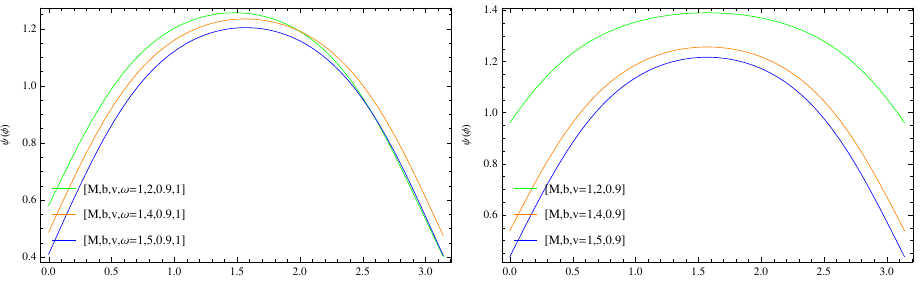
Figure 2. ( left ) Trajectory of the particle is shown, i.e., U ( φ ) against φ for different values of the impact parameter b . ( right ) U ( φ ) is shown against φ for different values of the impact parameter b , for Schwarzschild case.